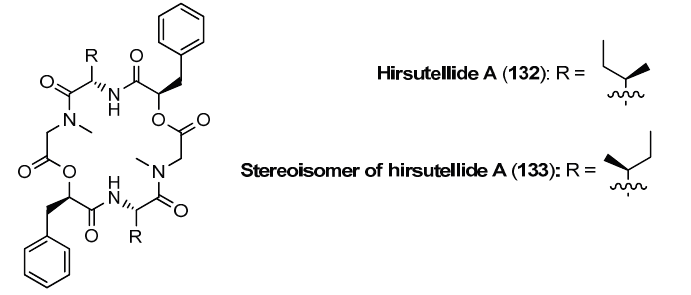
Figure 12. Structure of hirsutellide A and its